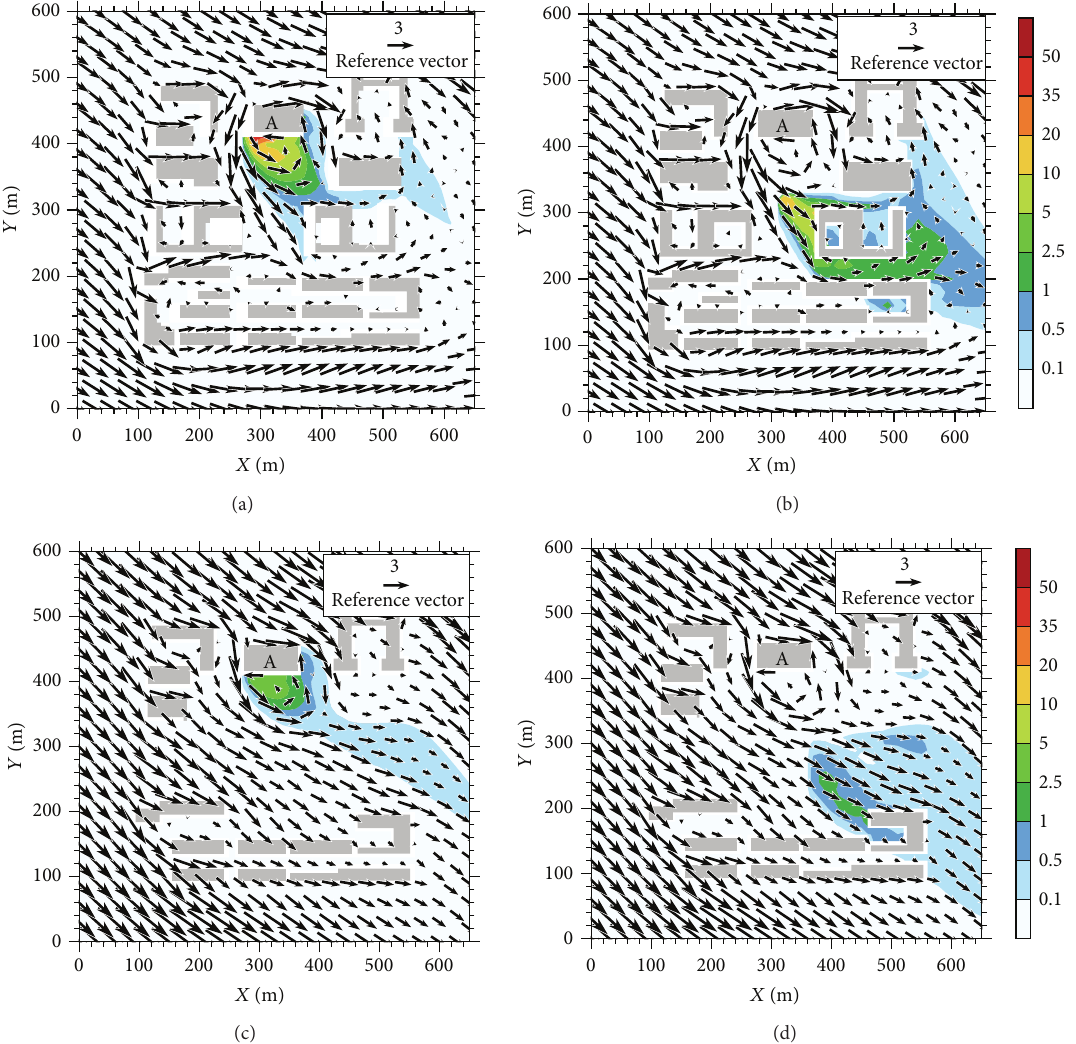
Figure 8: Simulated concentration (ppm) and wind vector fields at 2200 LST on 16th of February: (a, b) at 𝑧 = 2.5 m; (c, d) at 𝑧 = 22.5 m; (a, c) the point source was located at P1; (b, d) the point source was located at